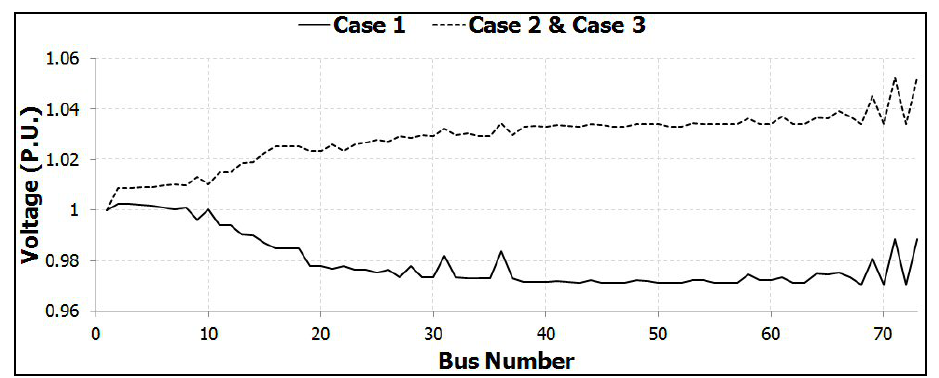
Figure 8. Initial voltage profiles for each